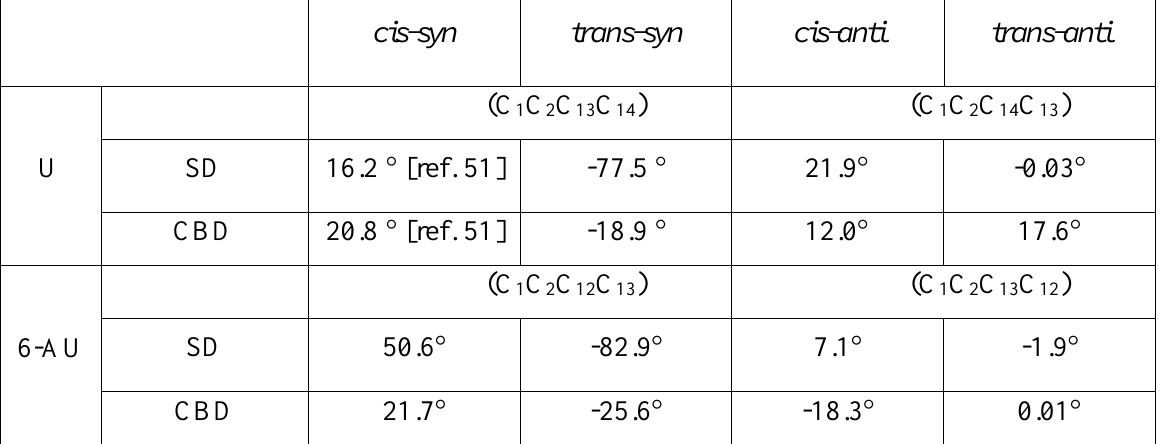
Table S2. Twist angles of the cyclobutane rings in U and